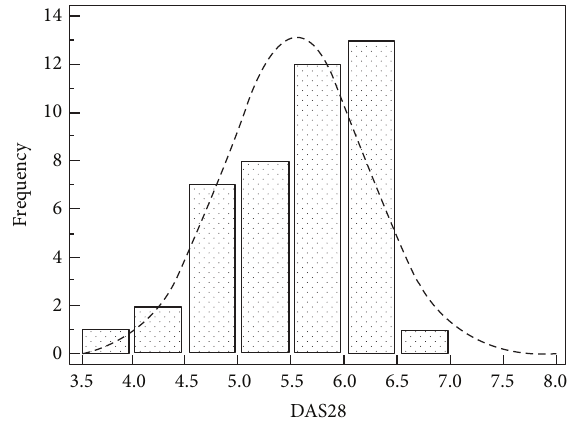
Figure 3: Estimates of central tendency and distributions of DAS28 in SLE patients.